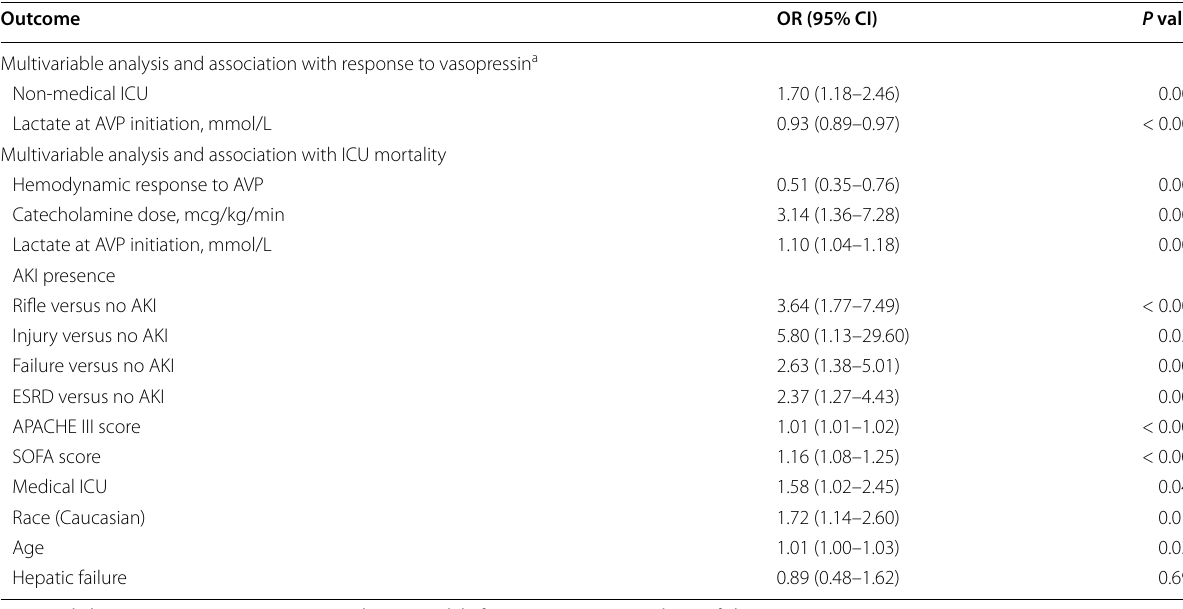
Table 3 Results of multivariable